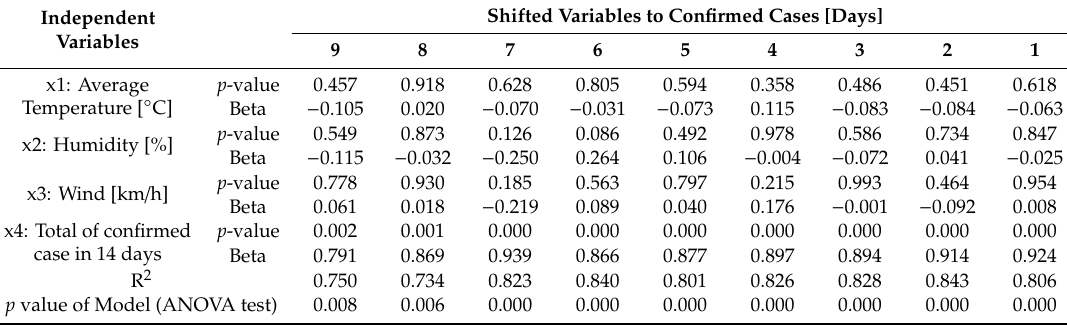
Table 3. The result of multivariate linear regression, Lombardy (Milan).